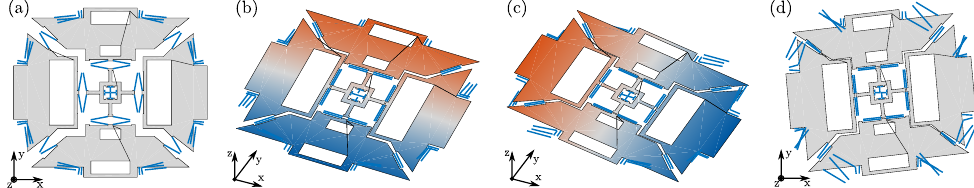
Figure 9. Modal shapes of the layout optimized by solving (P1) (Figure 8b): drive ( a ), pitch ( b ), roll ( c ), and yaw ( d ).